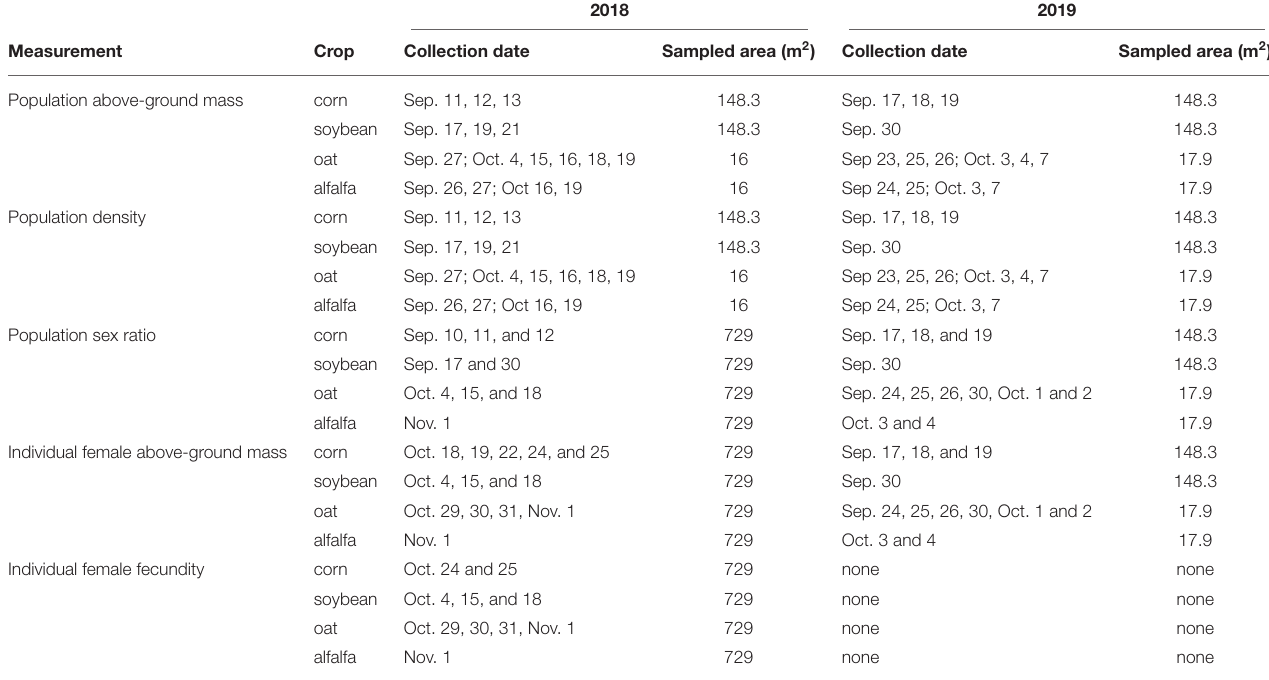
TABLE 3 | Sampling dates and areas in 2018 and